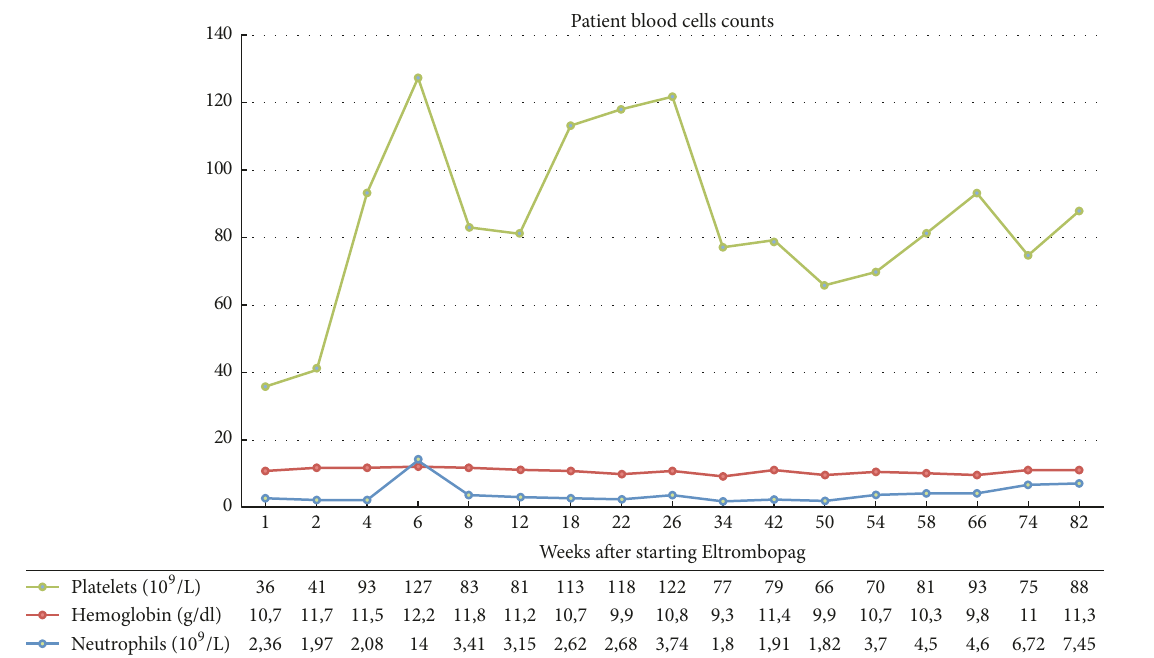
Figure 1: Patient platelet count after TPO-R agonist